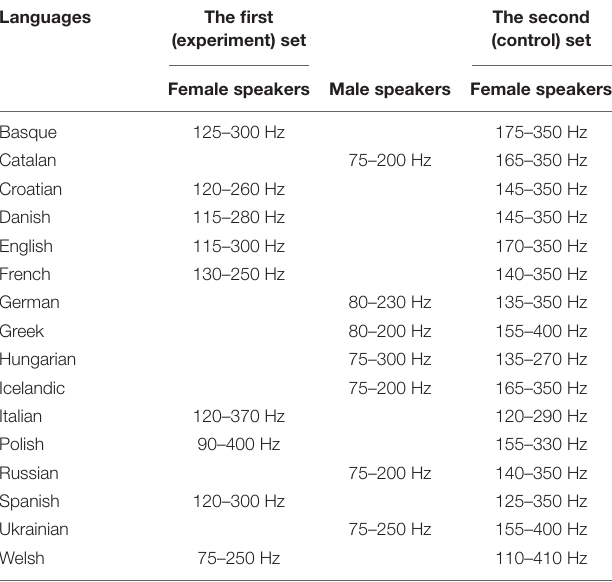
et al., and another strong pos. correlation of r = 0.76 ( p = 0.017) TABLE 1 | Frequency ranges across languages in the first and the second